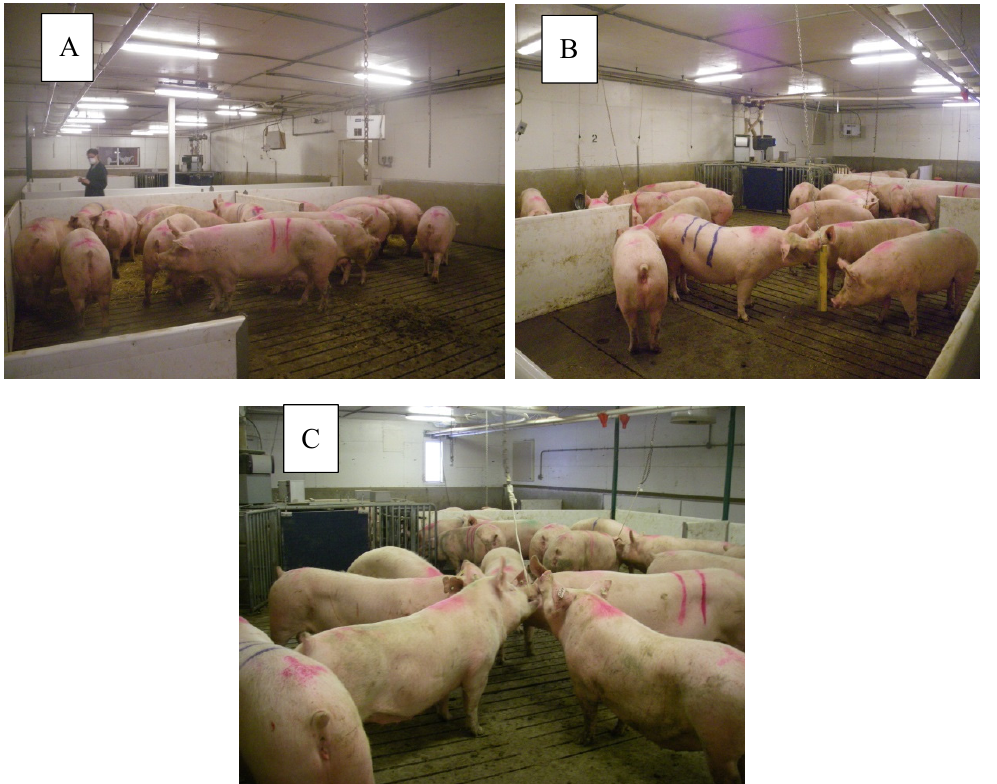
Figure 2. Photos illustrating presentation of straw ( A ), wood ( B ) and rope ( C ) enrichments to sows.